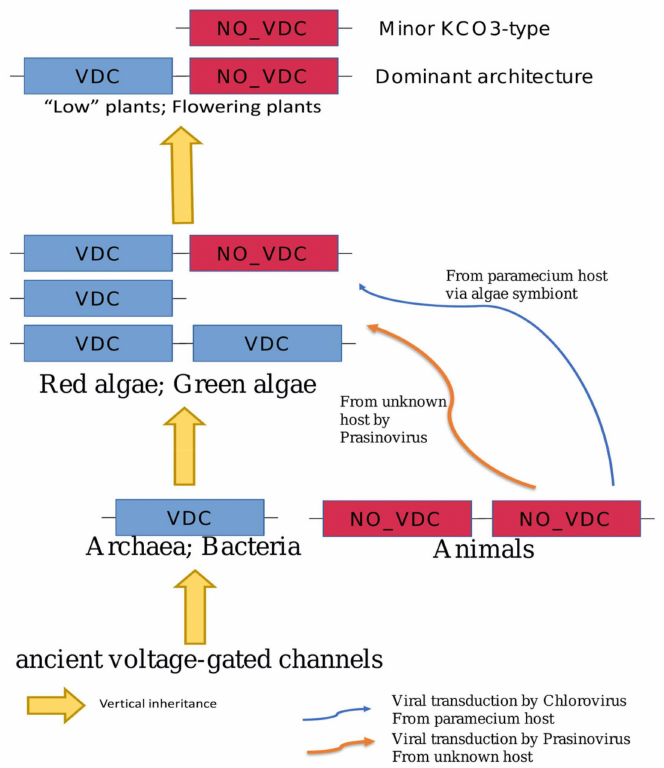
Figure 5. Simplified scheme of possible evolutional pathways of the TPK